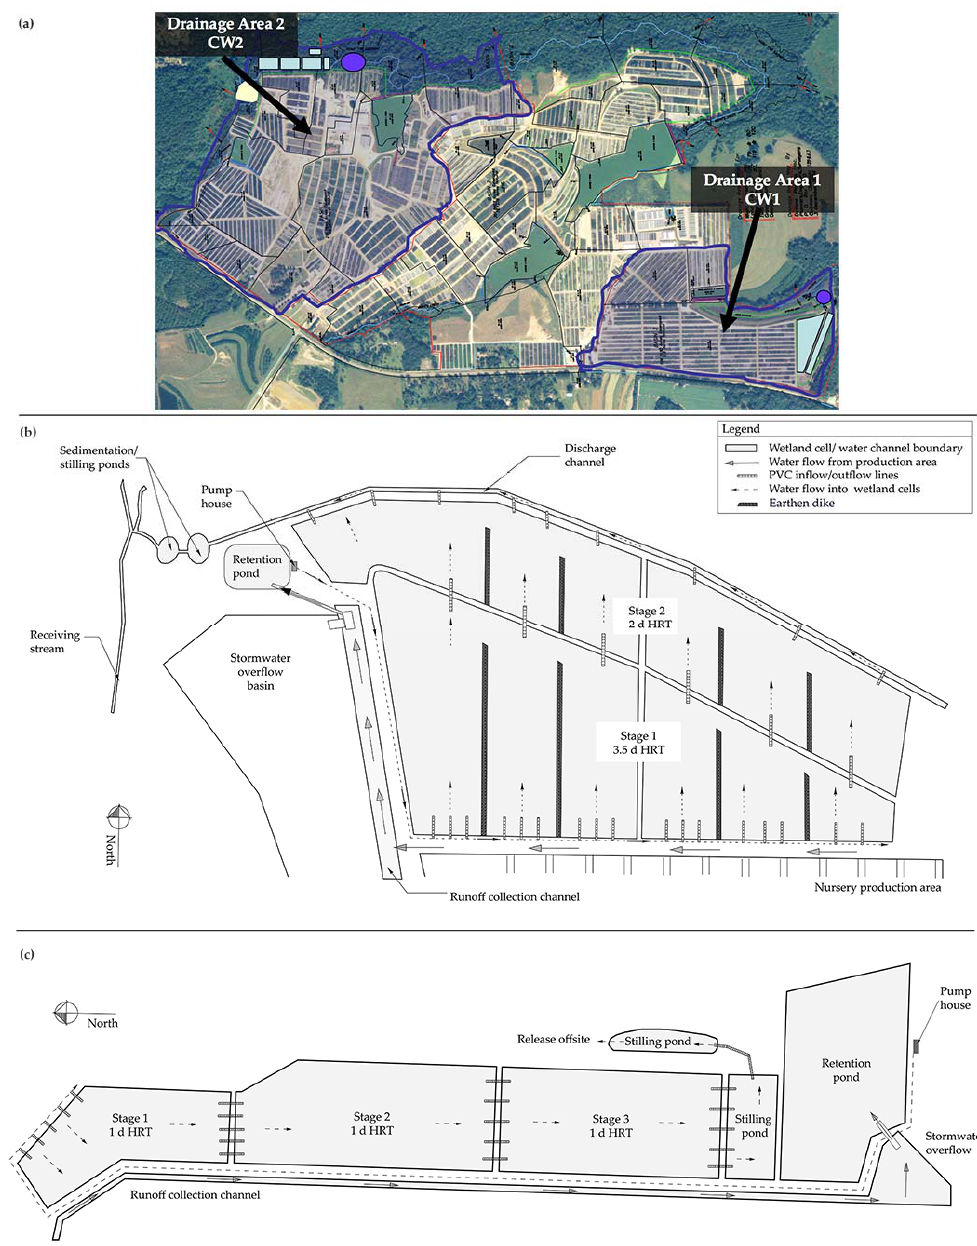
Figure 1. The two constructed wetlands monitored are southwest of the city of Cairo, GA, USA and treat runoff in the drainage areas ( a ) highlighted/bounded in dark blue at the ornamental plant nursery. Constructed Wetland 1 ( b ) receives irrigation runoff from drainage area 1. Constructed Wetland 2 ( c ) receives irrigation runoff from drainage area 2.